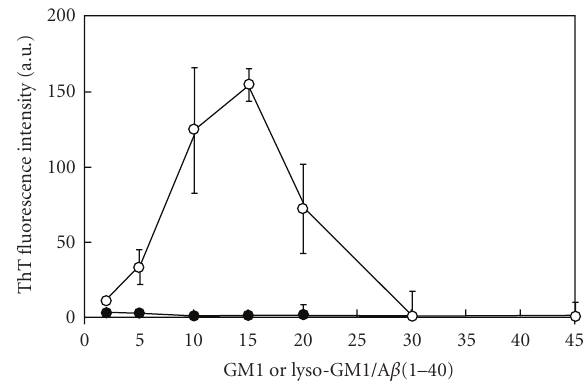
Figure 1: ThT fluorescence enhancement by A β (1–40) in the presence of varying concentrations of GM1 (open circle) or lyso- GM1 (closed circle). Each intensity value indicates the average of four values ± S.D.